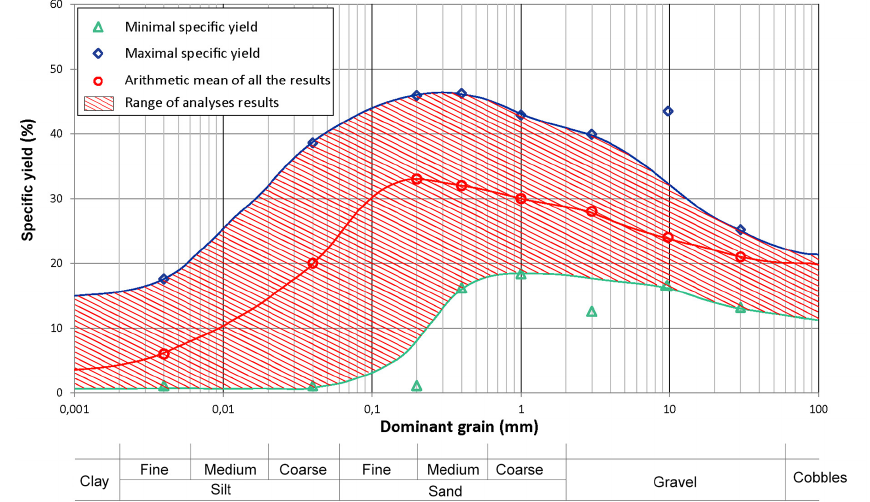
Figure 4. Range and arithmetic mean of specific yield values for 586 analyses in Hydrologic Laboratory of the USGS (from Morris and Johnson, 1967).